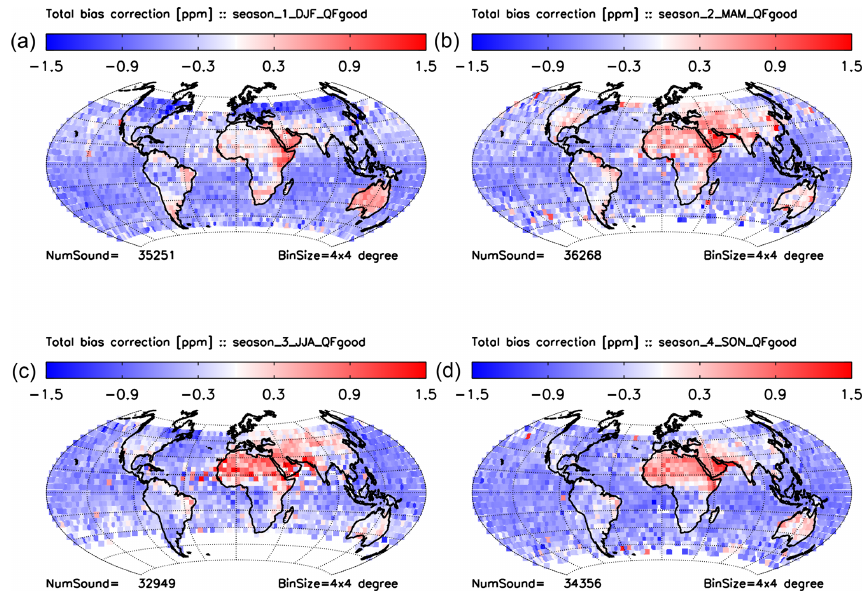
Figure 16. Seasonal maps of the total XCO 2 bias correction in 4 ◦ latitude–longitude bins for all soundings assigned a good QF. (a) DJF, (b) MAM, (c) JJA, and (d) SON.